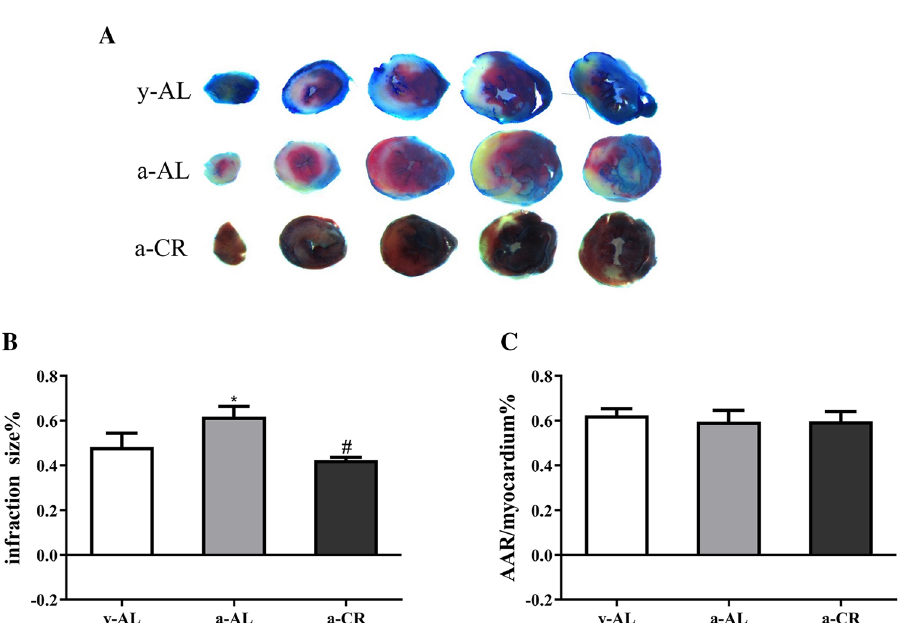
Figure 3. Size of myocardial infarction determined by Evan’s blue and TTC staining. ( A ) The result of Evan’s blue and TTC staining. The blue area is normal, and the remaining areas (including red and white) are ischemic risk zones (AAR), with white areas being myocardial infarction (IA) and red areas being ischemic but not infarcted. ( B ) Infarct size% was the ratio of IA to AAR. ( C ) AAR% was the ratio of AAR to the whole heart slide area. N = 5 for each group, group: y-AL youth fed ad libitum group, a-AL aged fed ad libitum group, a-CR aged caloric restriction group. One-way ANOVA was used to analyze the data. * P < 0.05 vs y-AL; # P < 0.05 vs